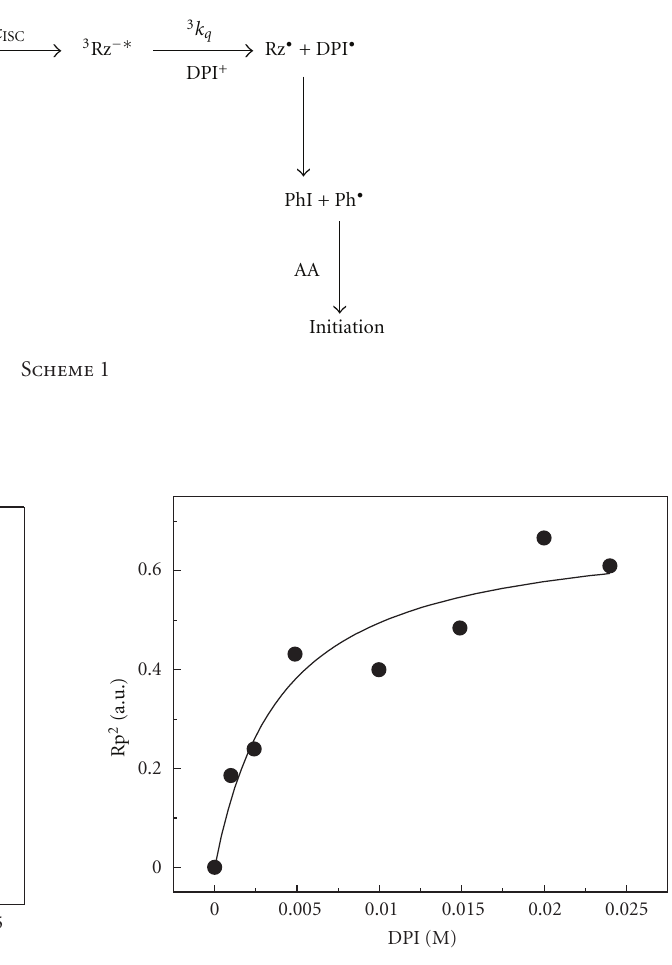
Figure 4: Plot of the square of the polymerization rate of AA 2M in water (pH = 10) in the presence of Rz 4 × 10 − 6 M as a function of DPI concentration. The solid line corresponds to the active radicals quantum yield calculated with the kinetics parameters obtained by laser flash